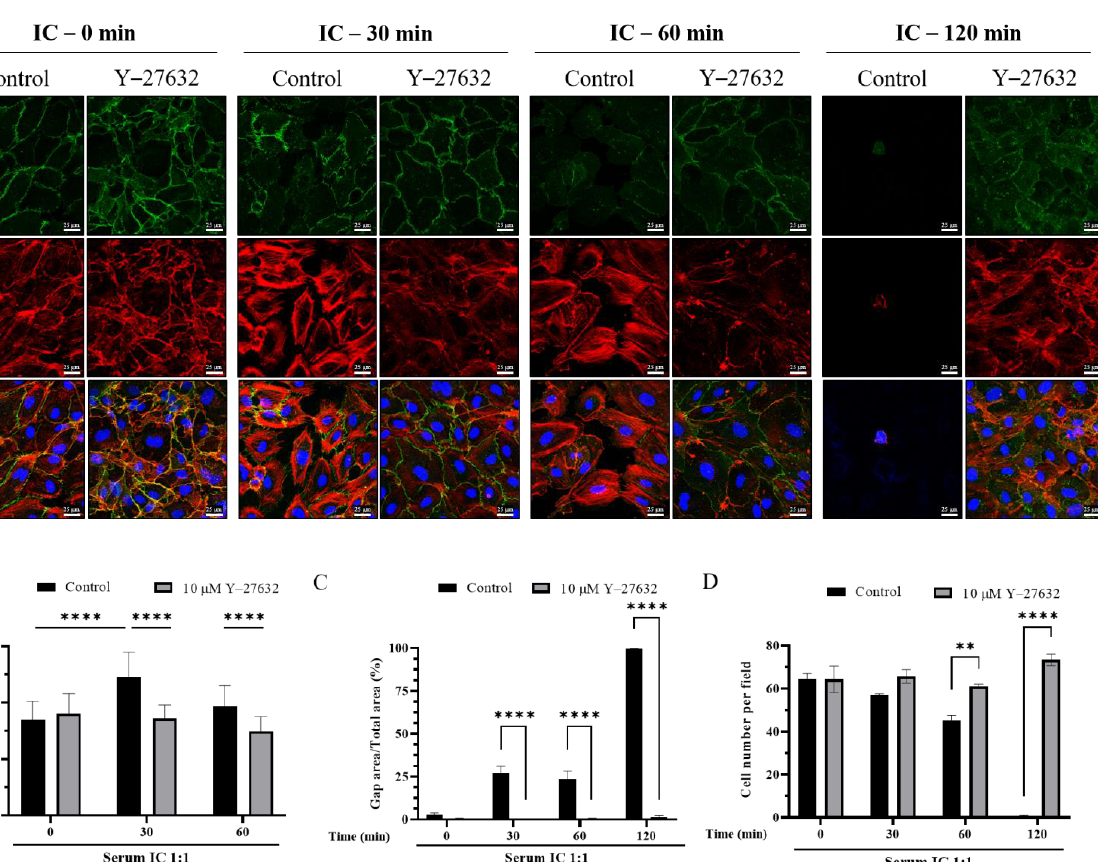
to stain nuclei and imaged at 40× and presented as merged images. Yellow color indicates regions of red and green colo- calization. ( C , D ) Cell surface imaging was performed by SEM and viewed at 10,000× (control) or 5000× (IC). Arrows denote regions of cell surface contact between adjacent cells.